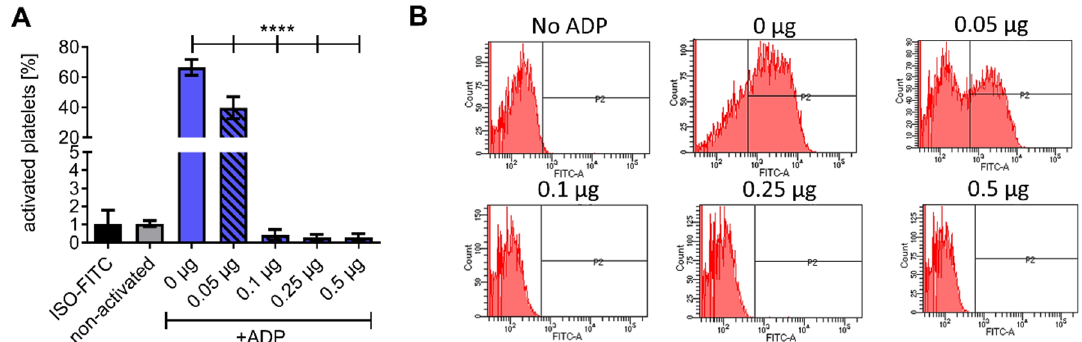
Figure 2. Functionality analysis of different concentrations of the HSA–CD39 construct. ( A ) Functionality analysis using flow cytometry detecting activated platelets through binding of the PAC-1 antibody, showing hydrolysing effects of CD39. ( B ) Representative fluorescence histograms of functionality analysis using flow cytometry. The different groups were compared using repeated-measures ANOVA and Bonferroni post hoc test. Values of 5 independent experiments are shown (% activated platelets ± SD, **** p < 0.0001).